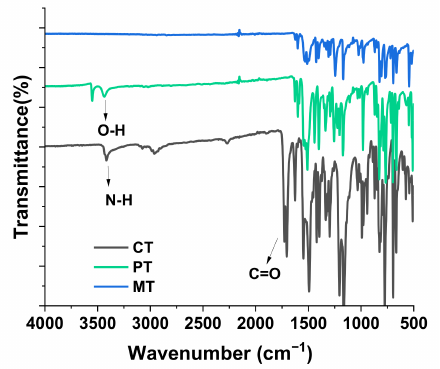
Figure 2. FTIR spectra of CT, PT, and MT.